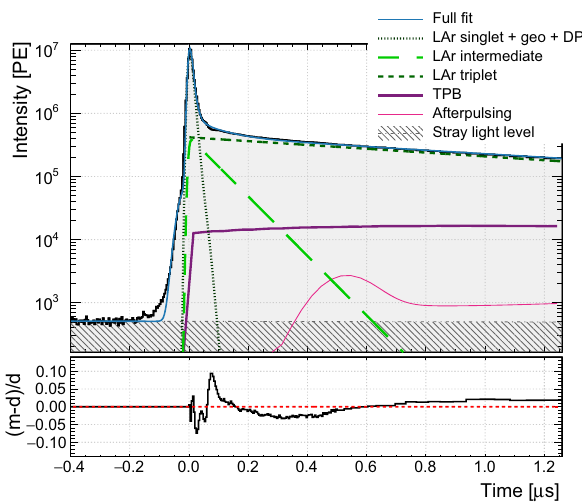
Fig. 9 The prompt region of the pulseshape is shown again but the shape of the LAr intermediate is described as a single exponential decay